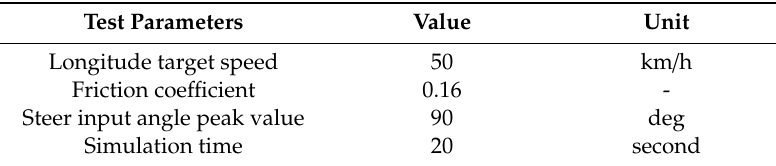
Table 7. Main parameters of sine wave steer input test.